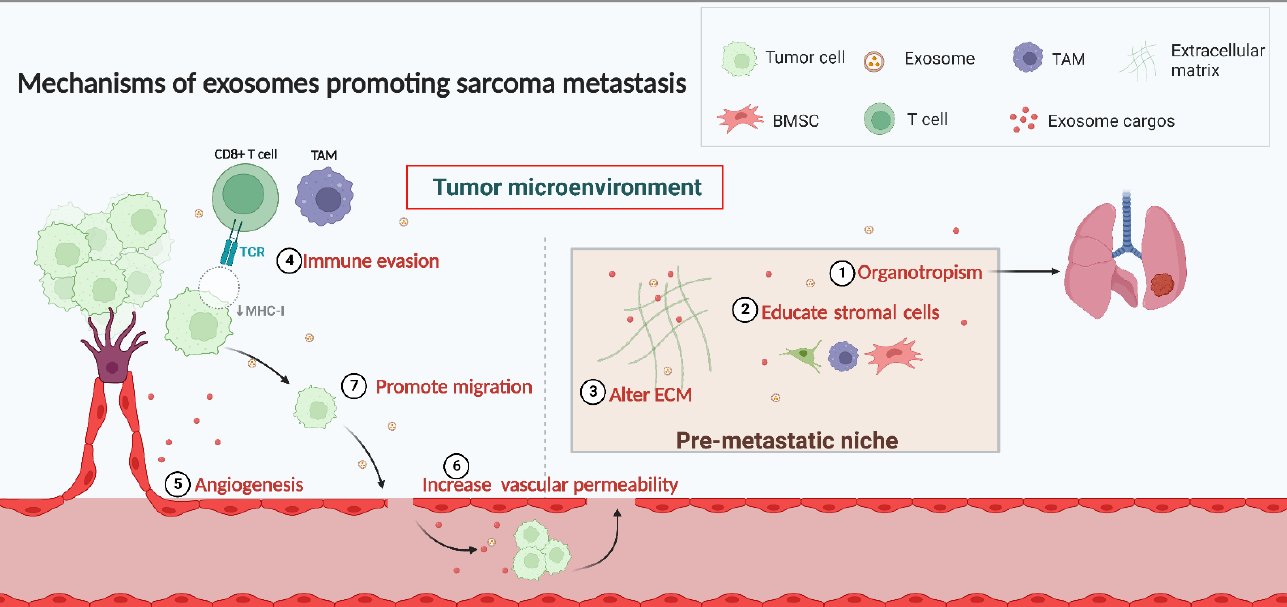
Figure 1. Mechanisms of exosomes in sarcoma metastasis.